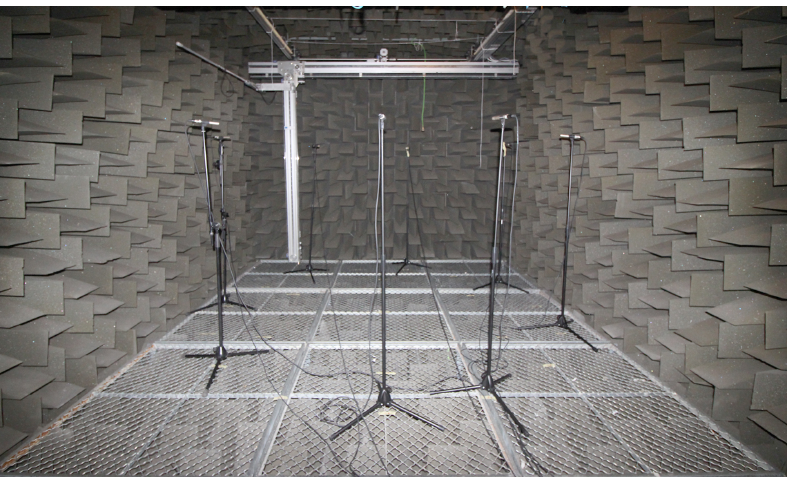
Figure 3. Anechoic chamber used for sound source characterization (School of Architects at the Polytechnic University of Valencia).